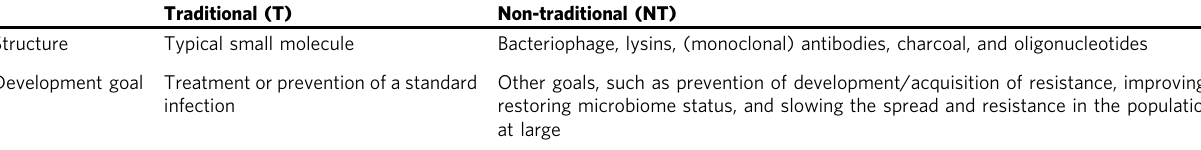
Table 2 Two categories of traditional (T) vs. non-traditional (NT) Traditional (T)